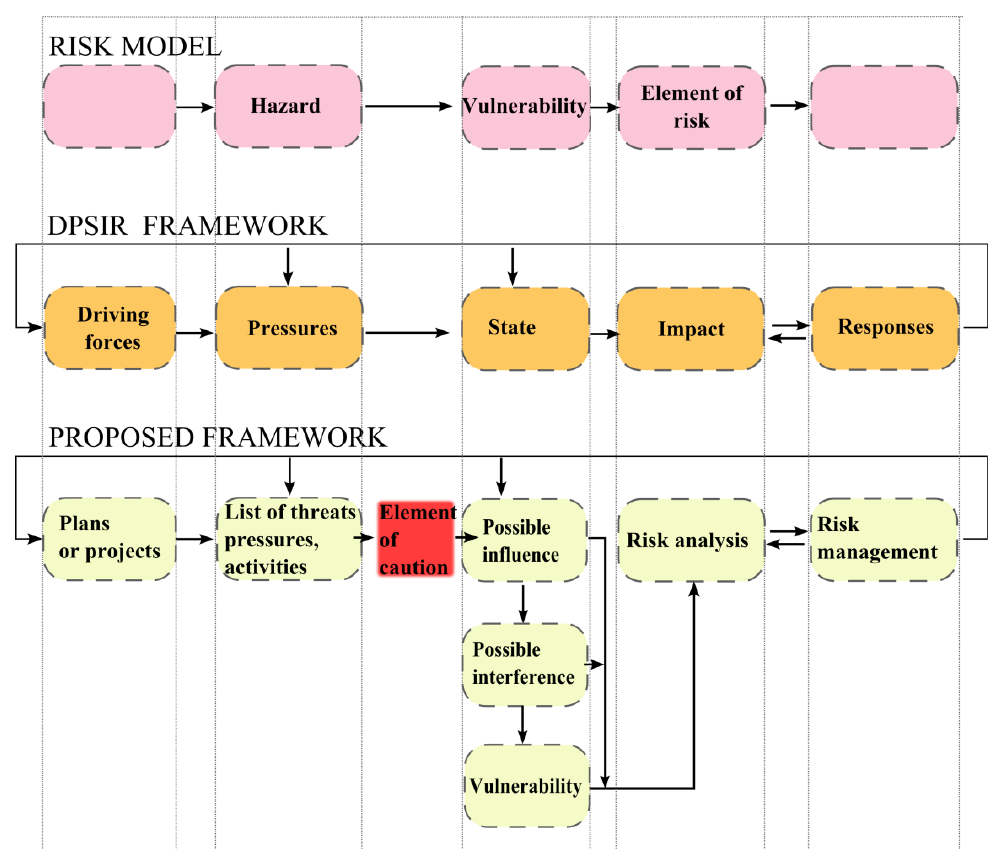
Figure 2. Comparison of the risk model between the proposed framework with the DPSIR